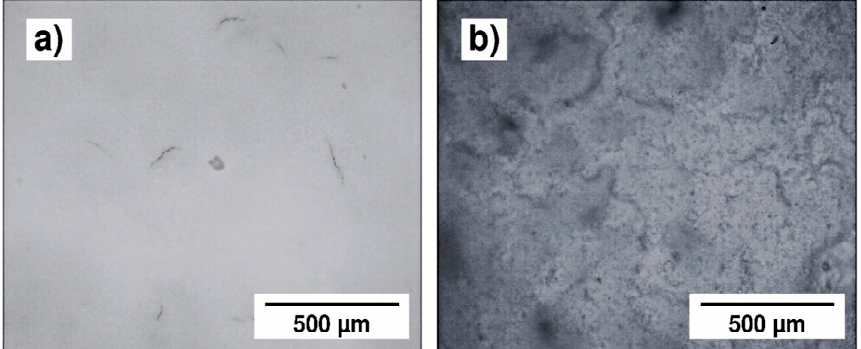
Figure 10. Optical micrographs of the 45S5 Bioglass ® coatings obtained by EPD at 30 V, ( a ) for 1 min and ( b ) for 2 min.